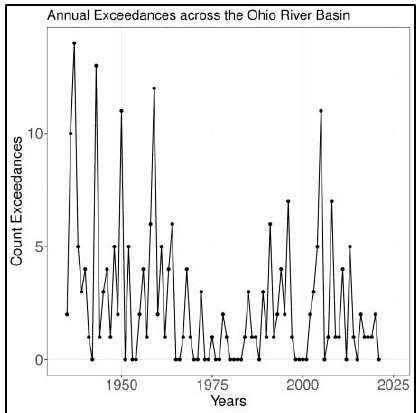
Figure 2. Number of annual maximum flows exceeding the at-site 10-year return period event each year across 24 streamflow gaging locations in the Ohio River Basin from the period 1935 to 2021.